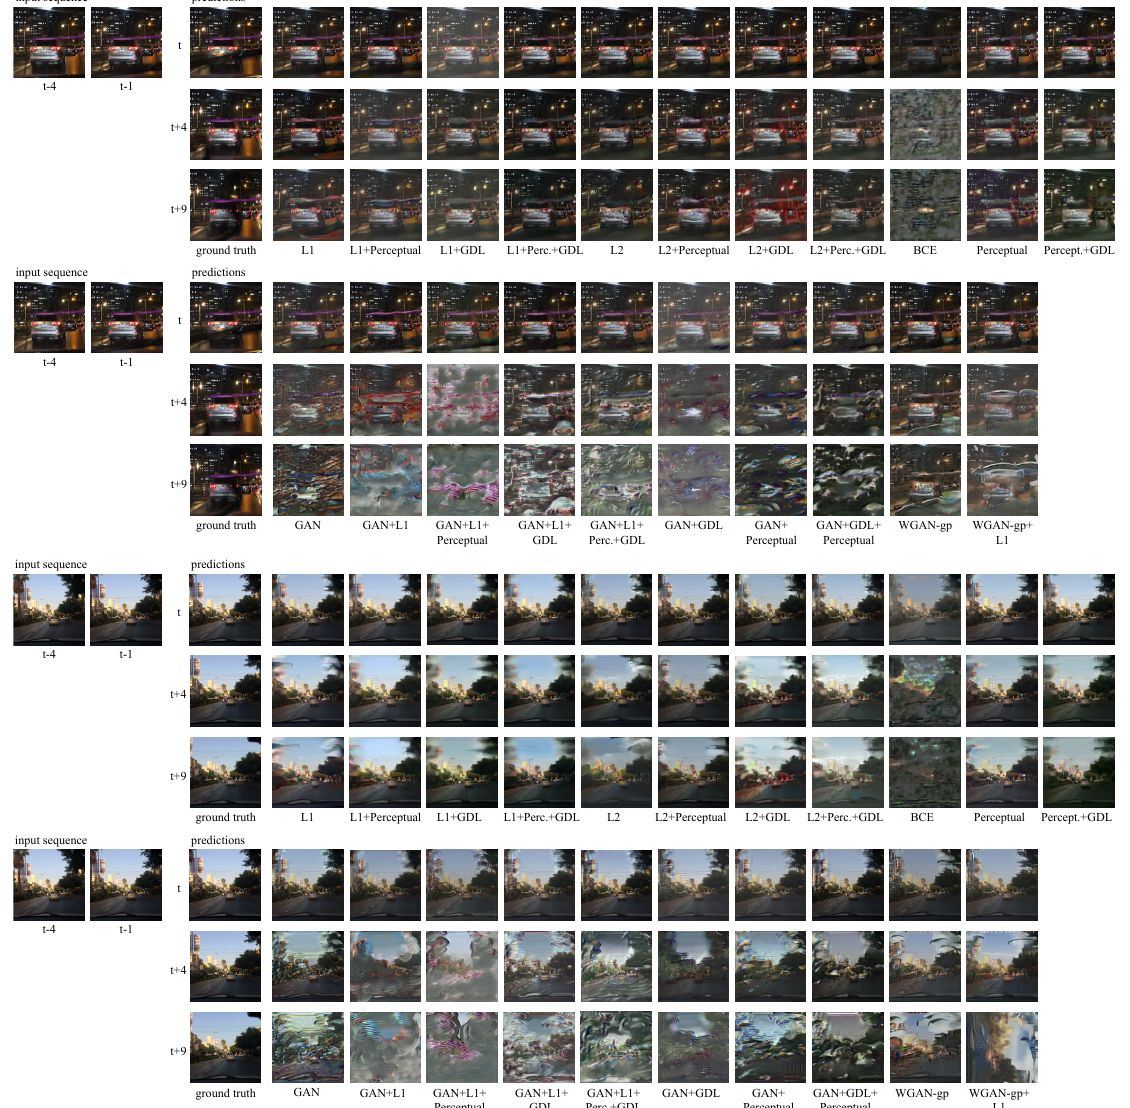
Figure A6. Qualitative results for the BDD100K test split. To generate these images, we used the models that were trained on Cityscapes for 20 epochs. The models were trained to predict the next frame based on four past frames. All images are included in the supplementary material. (The images are best viewed on